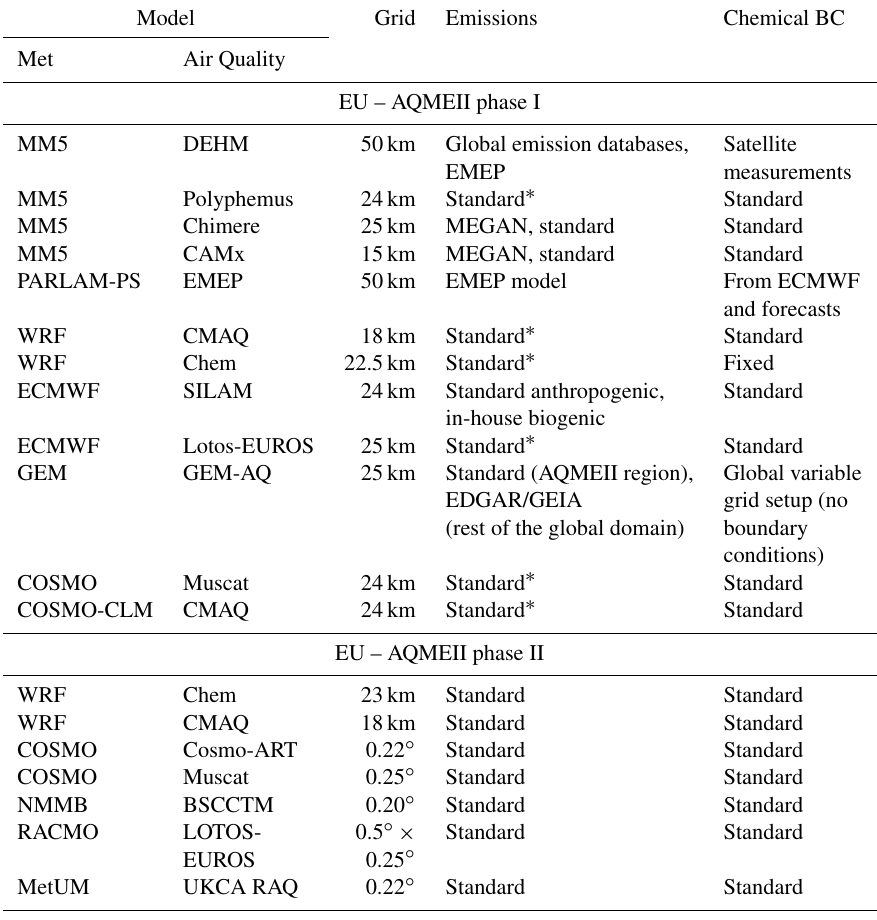
Table 1. The modelling systems participating in the first and second phases of AQMEII for